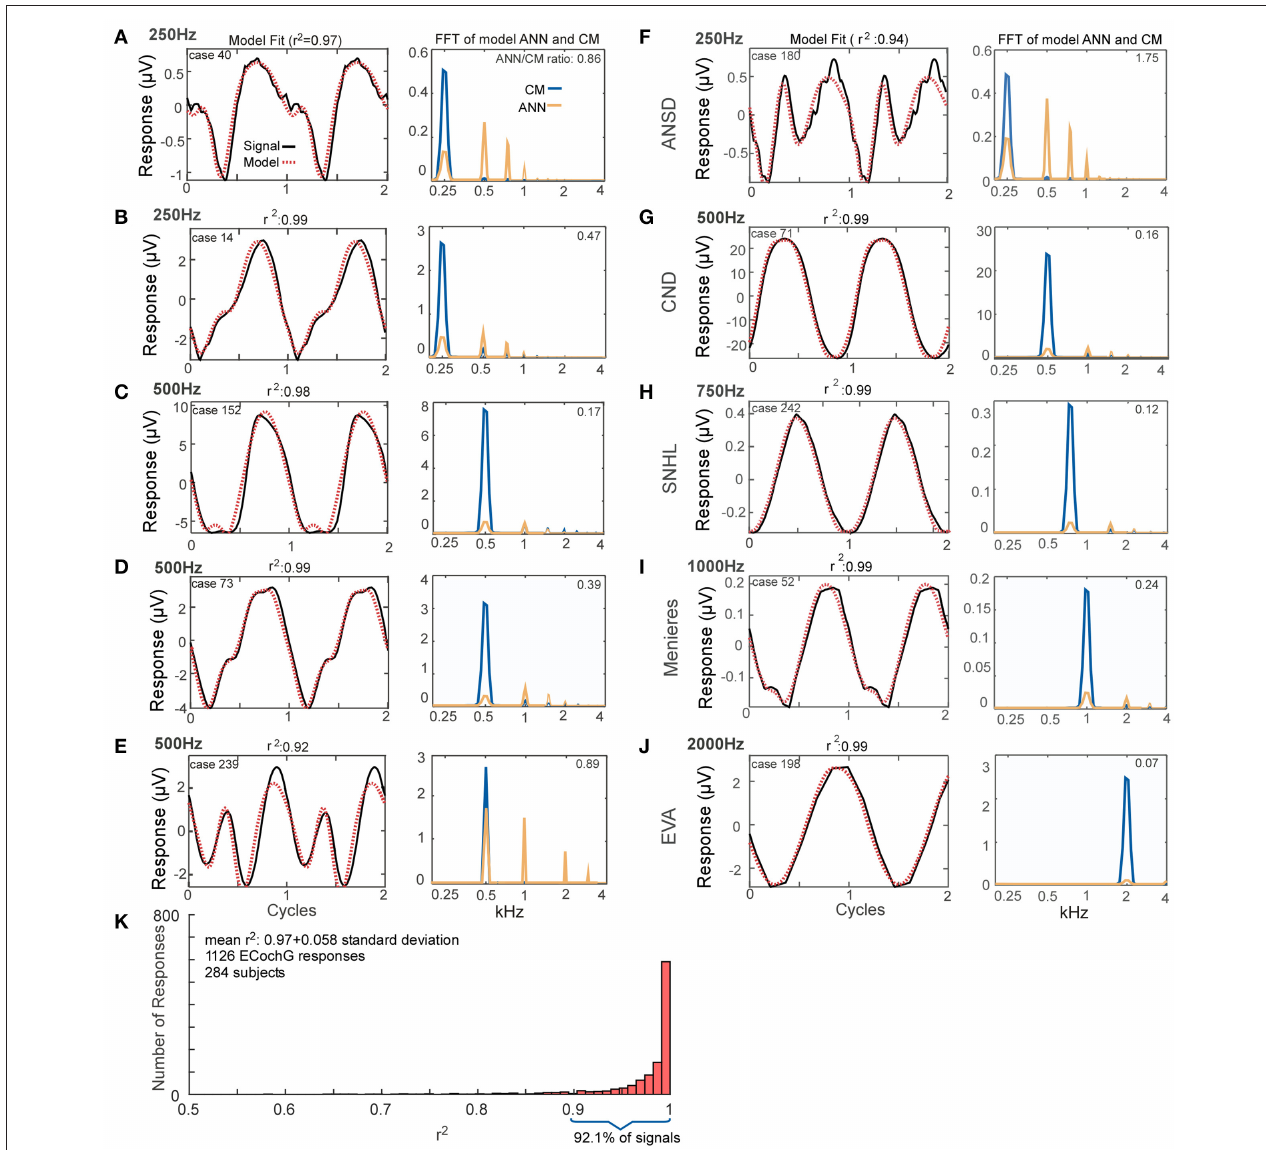
FIGURE 4 | Model fits to ECochG responses in human subjects. (A–E) Responses from different subjects to 250Hz (A,B) or 500Hz (C–E) show that the output of the model (left panels, red, dotted line) is able to reproduce the wide variety of waveforms seen in human CI subjects (solid black lines). From the model, the spectra of the CM and ANN used to produce the fit can be produced (right panels). For each case the linear fit between the two curves was described by the r 2 value, and the ANN/CM ratio is given for the spectra. (F–J) Similar to the previous examples, except these cases are from subjects with different hearing loss etiologies, to indicate the heterogeneity of causes leading to cochlear implantation (ANSD, auditory nerve spectrum disorder; CND, cochlear nerve deficiency, SNHL, unknown cause of sensineural hearing loss; Meniere’s, Meniere’s disease; EVA, enlarge vestibular aqueduct). The responses are shown in order of increasing stimulus frequency. The spectrum of the ANN is slightly displaced for clarity. (K) Across all recordings ( n 1,126) from 284 subjects, the model was able to fit observed ECochG signals with = an mean r 2 of 0.97 0.058 (standard ±